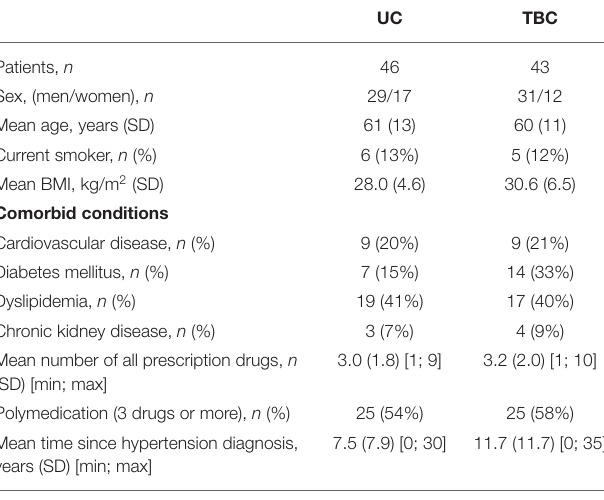
TABLE 1 | Baseline characteristics of the patients.